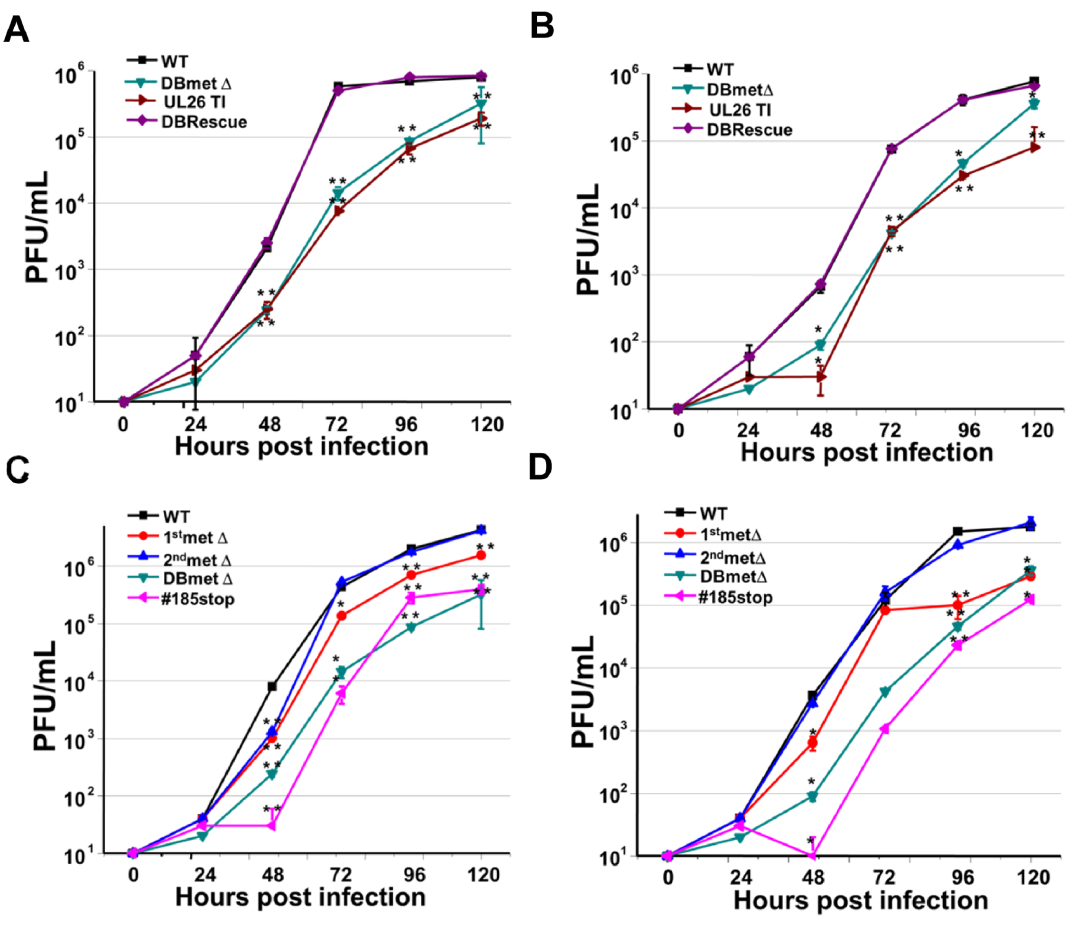
Figure 2. Growth characteristics of U L 26 recombinant viruses. Serum starved MRC5 fibroblasts were infected with WT, UL26TI, DBmet D or DBrescue viruses at an MOI of 3.0 ( A ) or 0.25 ( B ) in triplicate. For C & D , cells were infected with WT, 1 st met D , 2 nd met D , DBmet D or # 185stop at an MOI of either 3.0 ( C ) or 0.25 ( D ). Supernatants were harvested at the indicated times, and infectious viral progeny was quantified by plaque assay on fibroblasts. Values are means 6 SE (n $ 3), and statistical significance was assessed through comparison of mutant to WT titer at the same time post infection by student’s ttest, *=p , 0.05; **=p , 0.01.